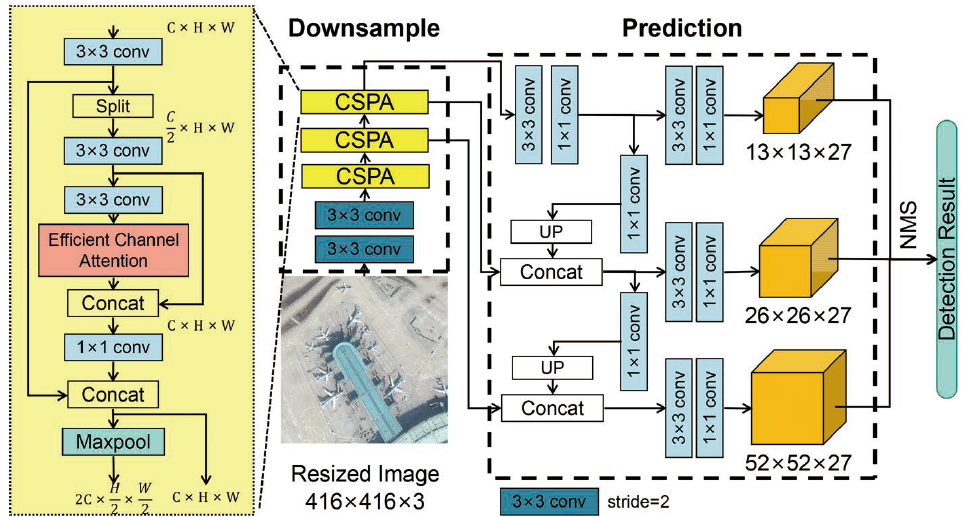
Figure 2. The proposed lightweight neural network for remote sensing object